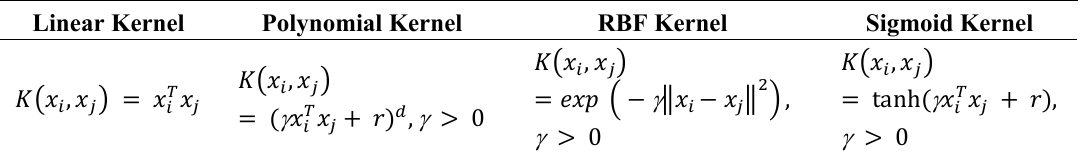
Table 3. Mathematical equations of the most widely used kernel functions (“  ” is the gamma term, “d” is the polynomial degree term, and “r” is the bias